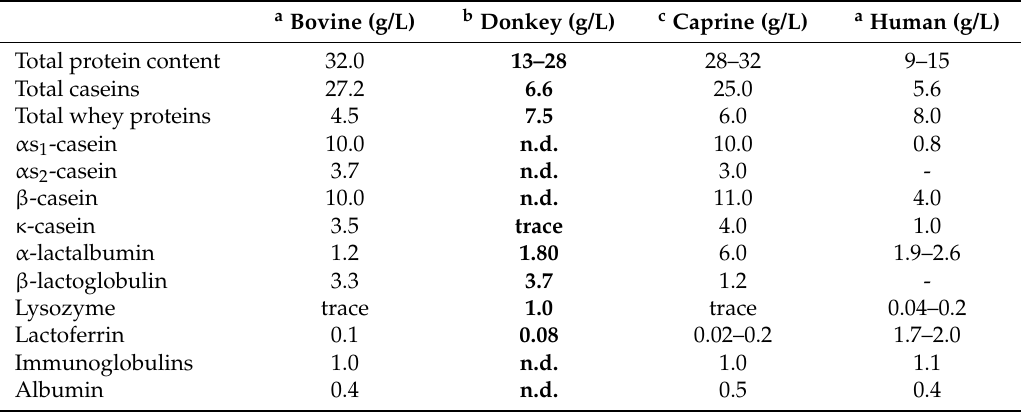
Table 5. Main proteins content in donkey milk (evidenced in bold) and comparison with bovine, caprine, and human milk.